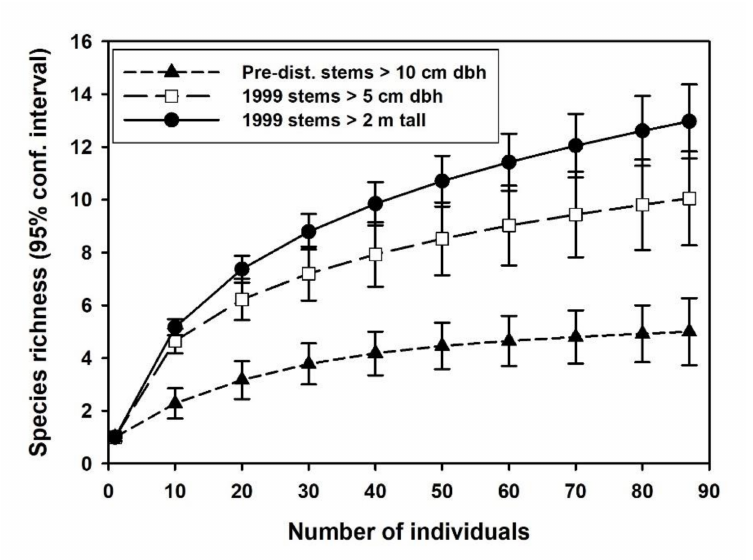
Figure 4. Species-accumulation curves for pre-disturbance canopy trees and two size classifica- tions of post-disturbance woody vegetation in 1999 (combining survivors and new recruits). Error bars = 95% confidence intervals.